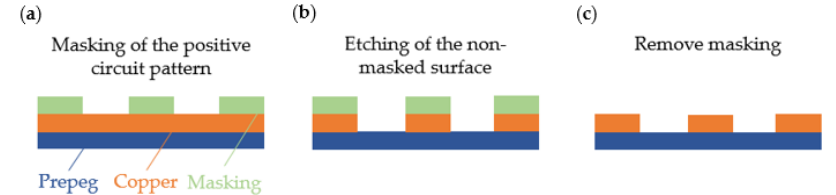
Figure 2. Subtractive technology ( a ) masking of the positive circuit pattern ( b ) etching of the non- masked surface ( c ) removing masking.